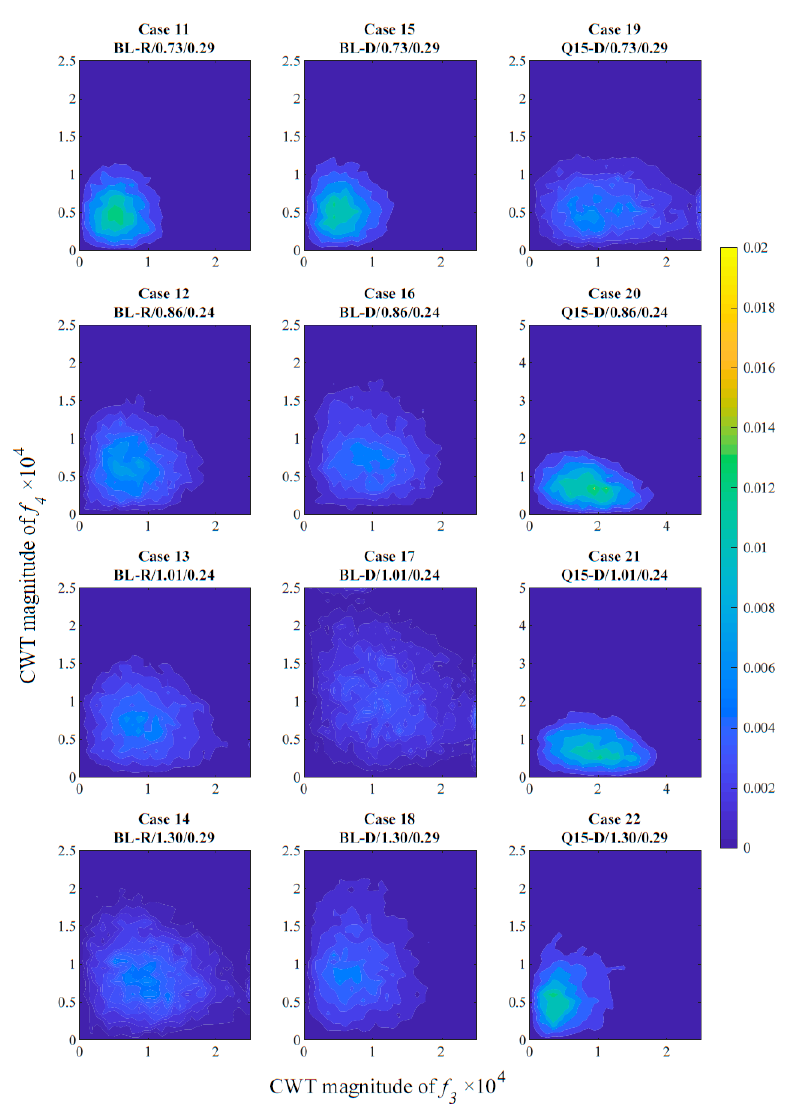
Figure 9. Comparison of BL-R ( left , Cases 11–14), BL-D ( middle , Cases 15–18), and Q15-D ( right , Cases 19–22) at the same conditions at each row. The first number after the setup name notes λ , which is followed by S . The points picked at similar S values in the weak swirl regime. Note the doubled axis limits in Cases 20 and 21.